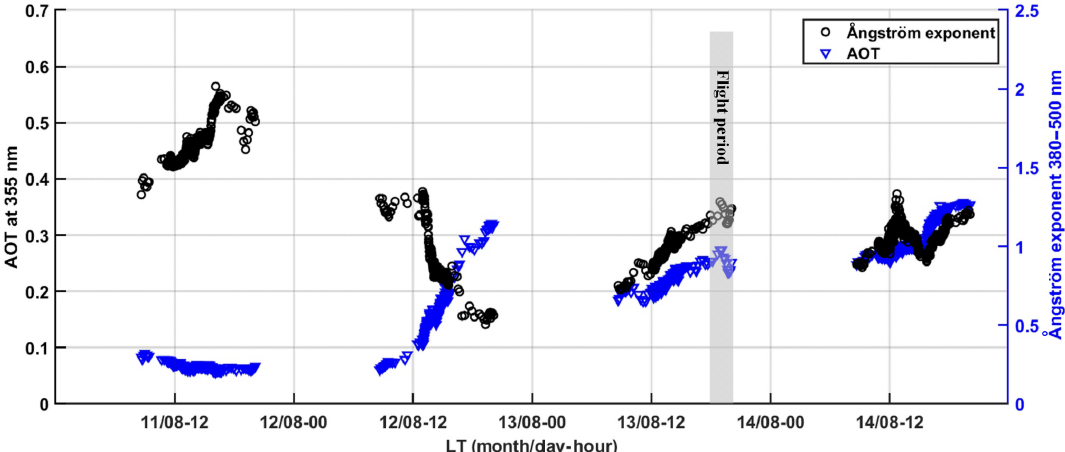
Figure 3. Temporal evolution in local time (LT) of both the aerosol optical thickness (AOT) and Ångström exponent between 380 and 500nm. The flight period is highlighted by the grey